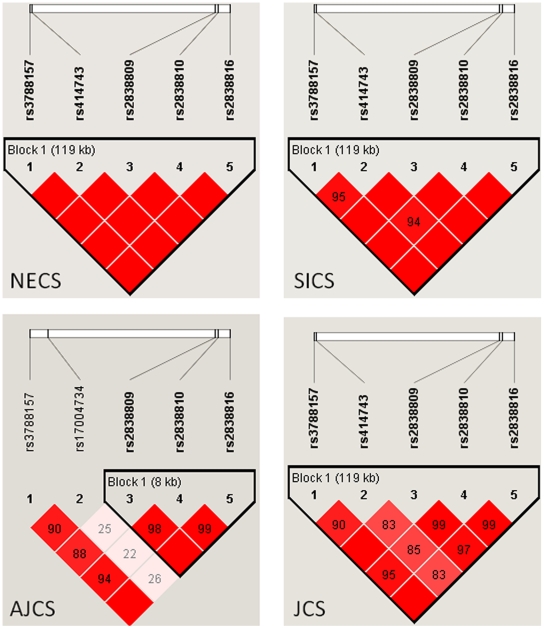
Pattern of LD among the SNP in ADARB1 (chromosome 21) that are associated with exceptional longevity.The four plots display the pattern of LD captured by the SNPs associated with exceptional longevity in ADARB1 (chromosome 21) using data from the NECS, SICS, AJCS and JCS. The intensity of red represents the strength of LD measured by D′.